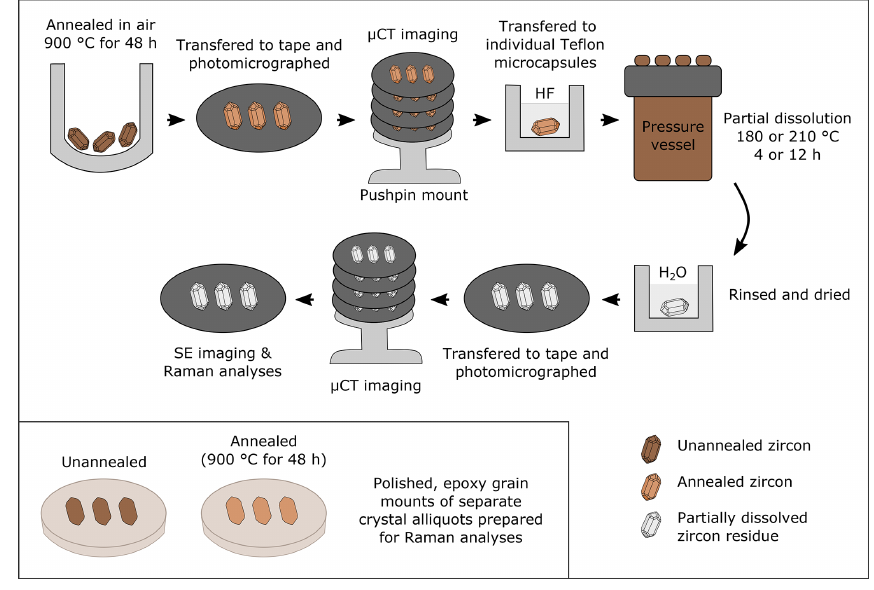
Figure 1. Summary of our experimental workflow.